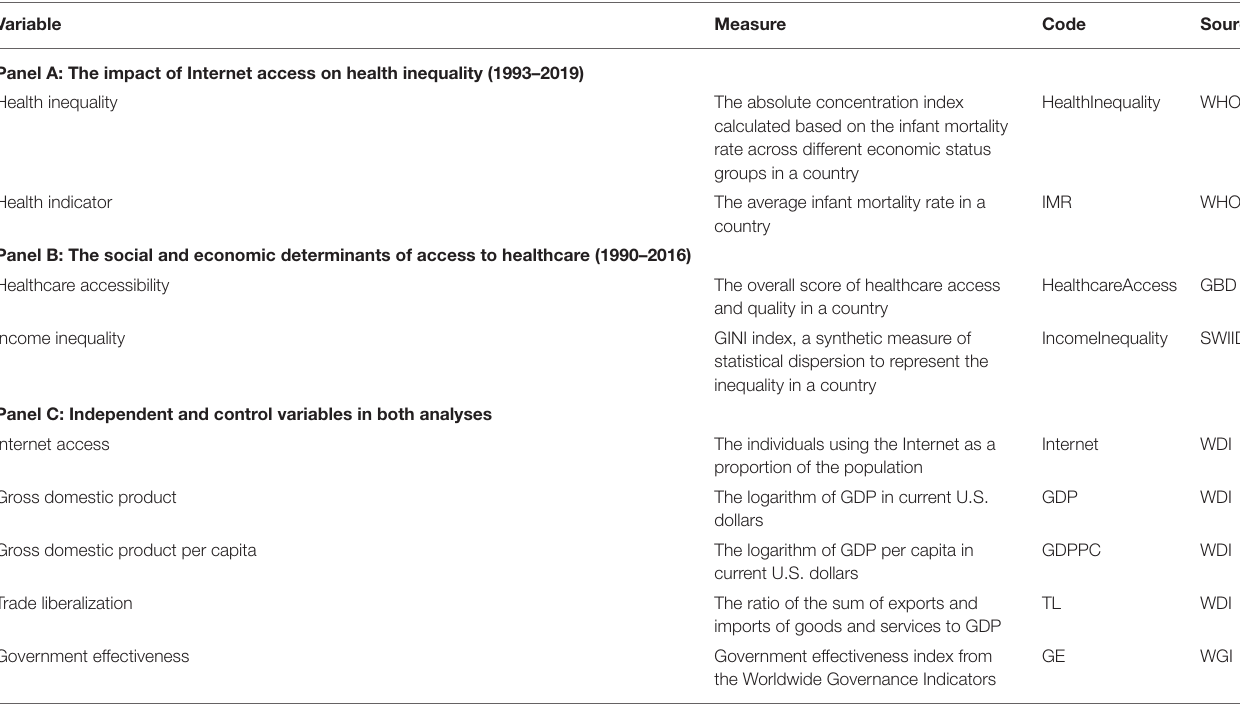
TABLE 1 | Summary of